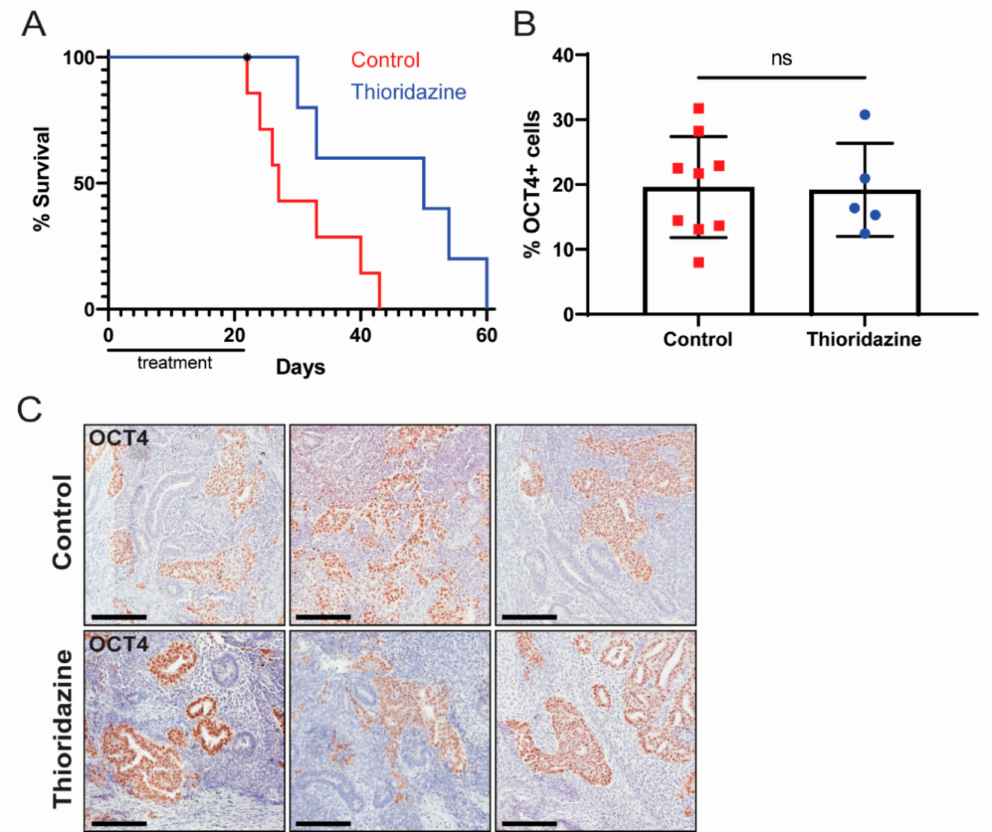
Figure 6. Thioridazine treatment of mice bearing human EC cell xenografts extends survival. Rag2KO mice were bilaterally injected with 10 million NT2D1 cells. When the tumors were palpable, mice were treated via intraperitoneal injection with thioridazine (25 mg/kg) or vehicle alone (0.9% NaCl) every three days for three weeks (seven doses total). Mice were euthanized when tumors reached 2 cm in diameter or other humane endpoint criteria were met. ( A ) Kaplan–Meier survival curve depicting extension of survival in thioridazine-treated mice ( n = 6) compared to control mice ( n = 7). One thioridazine-treated mouse was found dead and therefore censored (as indicated by an asterisk). p < 0.05 (Log-rank test). ( B ) Quantification of OCT4-positive cells in tumors from thioridazine- treated and control mice as determined by OCT4 IHC. Data are mean values ± standard deviation. ns = not significant (Unpaired t -test). ( C ) Representative images of OCT4 IHC-stained tumors from thioridazine-treated and control mice. Scale bars = 200 µ